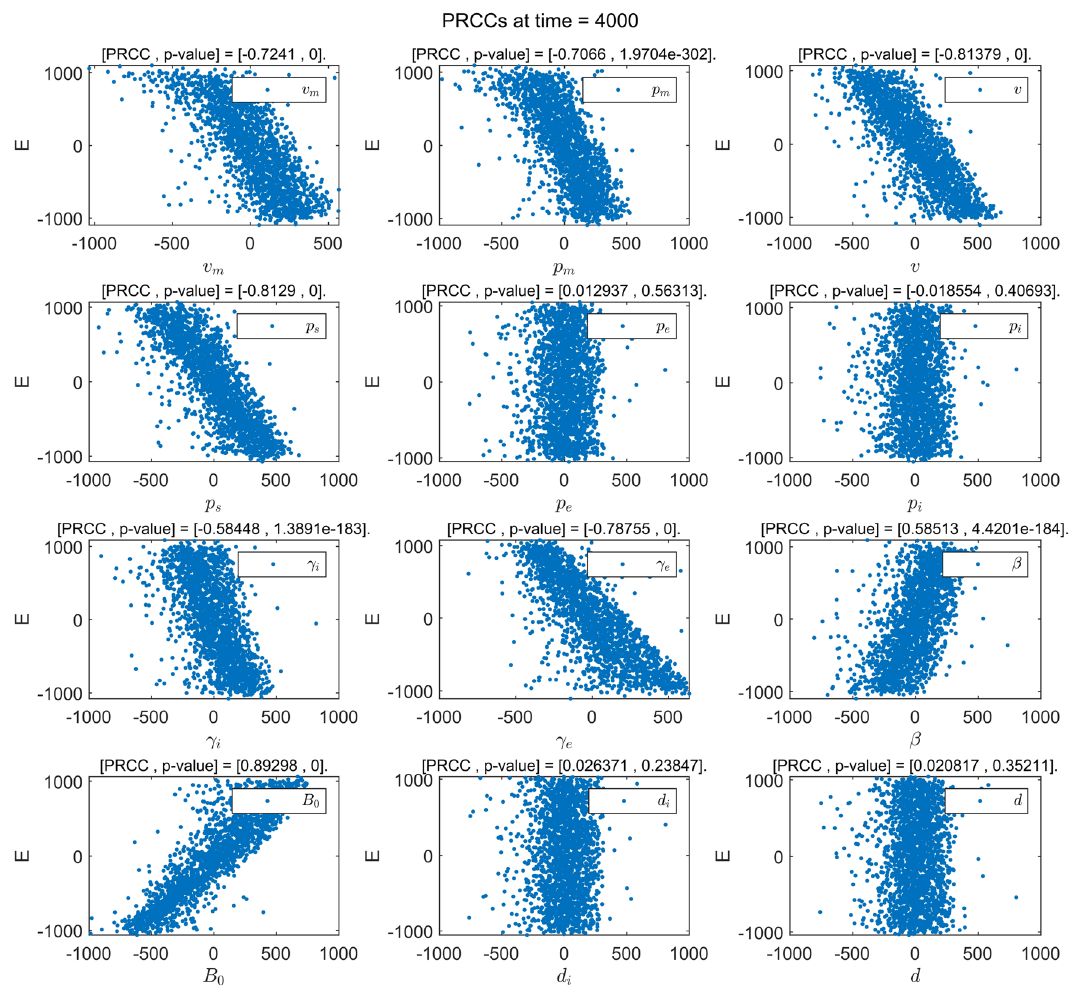
Figure 3. Scatter plot of PRCC value for each parameter in E ( t